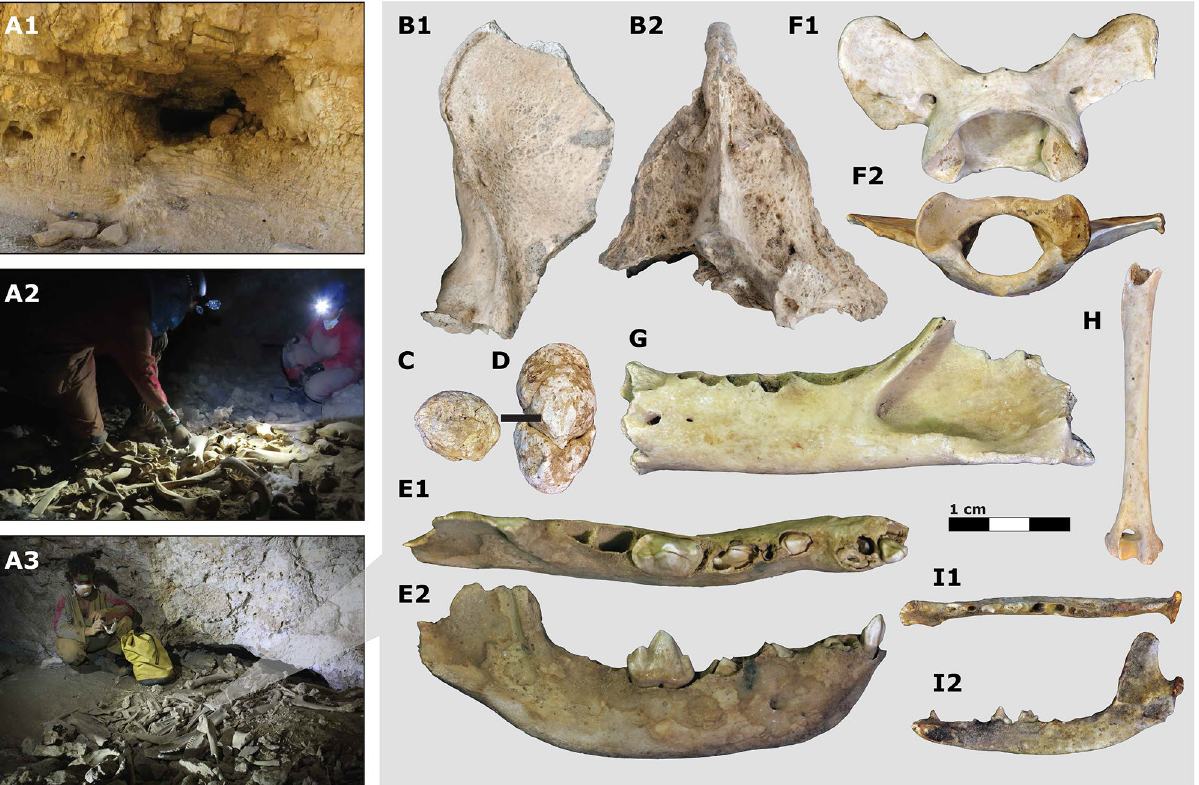
in A3 by Boaz Langford used with permission. Selected large carnivore specimens, including a H. hyaena occipital in ( B1 ) lateral and ( B2 ) posterior views, ( C – D ) H. hyaena coprolites, a juvenile right H.